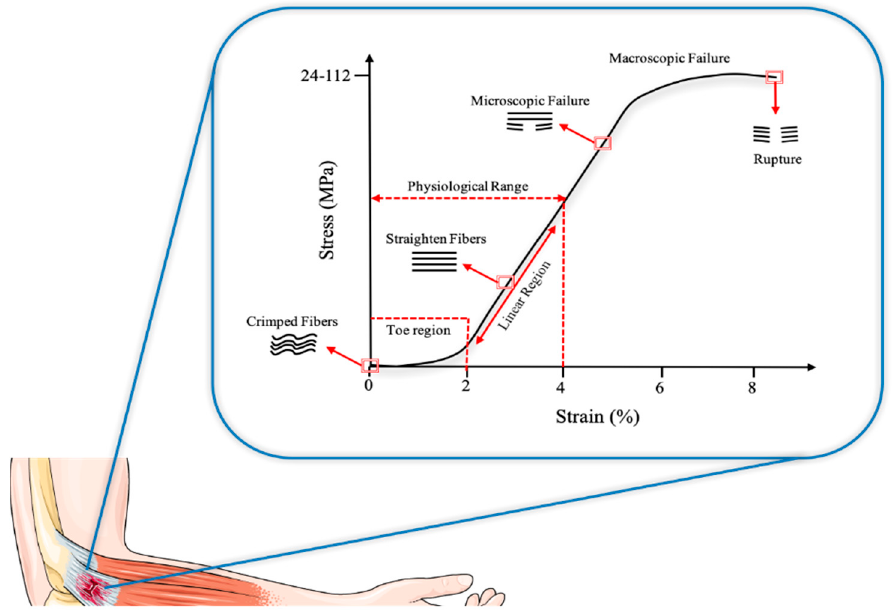
Figure 3. Typical stress–strain curve for tendon tissue. The schematization illustrates the behavior of collagen fibers: under tensile strain, they stretch out absorbing shock, and when the stimulus disappears, they return to their initial configuration. If the stretching limit is exceeded, overcoming the physiological range, the tissue may su ff er microscopic and macroscopic traumas. Adapted from